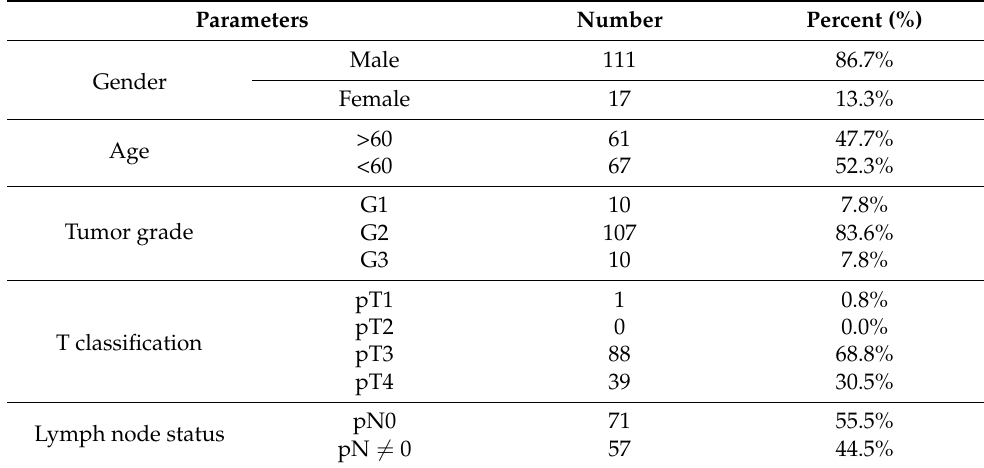
Table 1. Characterization of LSCC (laryngeal squamous cell carcinoma) patients. Tumor size and lymph node status according to pathological (p) TNM (T-tumor; N-lymph node involvement; M- distant metastases) classification (7th edition) by UICC (The Union for International Cancer Control).